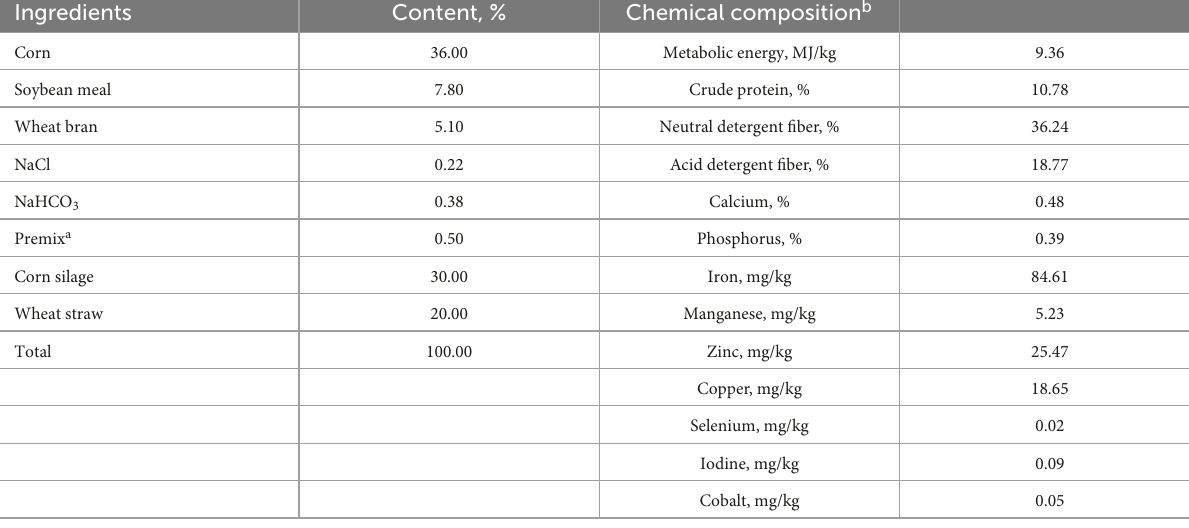
TABLE 1 Ingredients and chemical composition of basal diet (DM